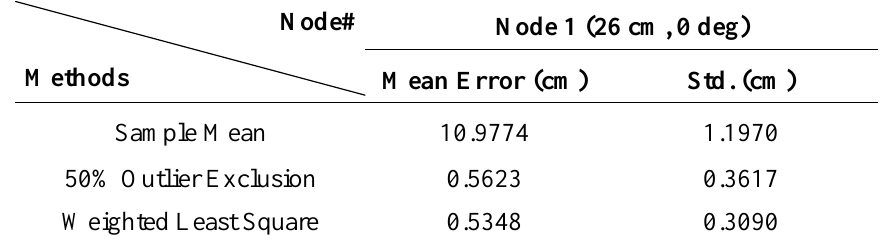
Table 5. The mean error and standard deviation of the repeated tests for the MEMS